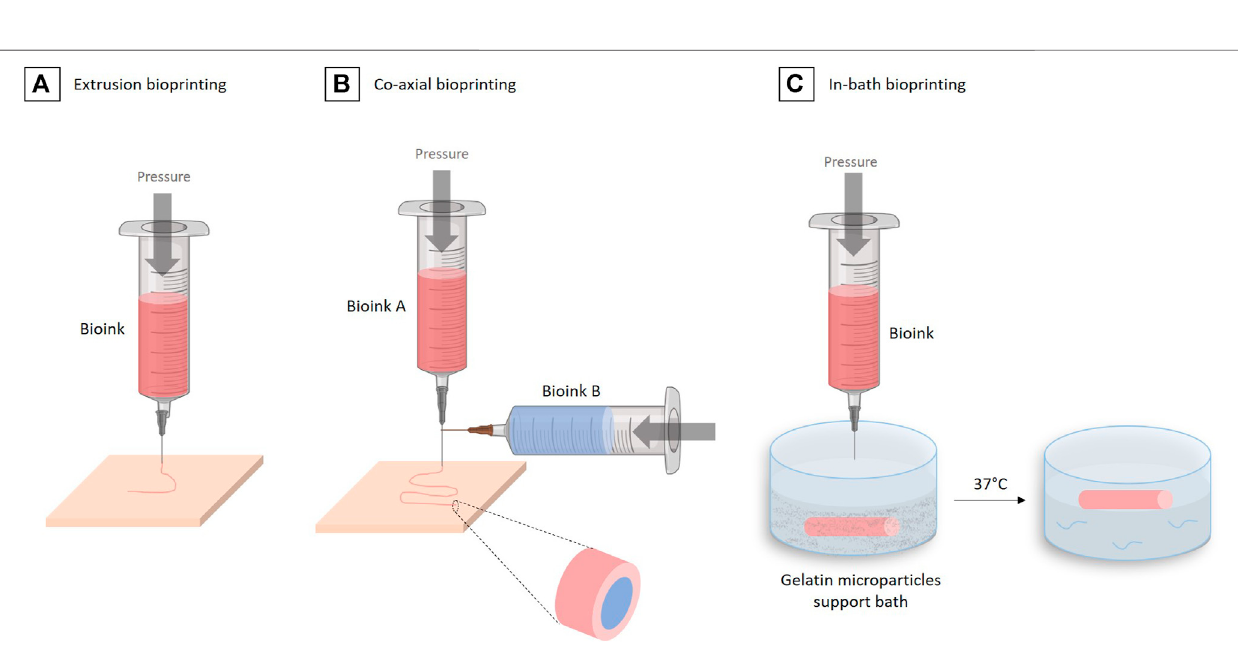
Frontiers in Bioengineering and Biotechnology |